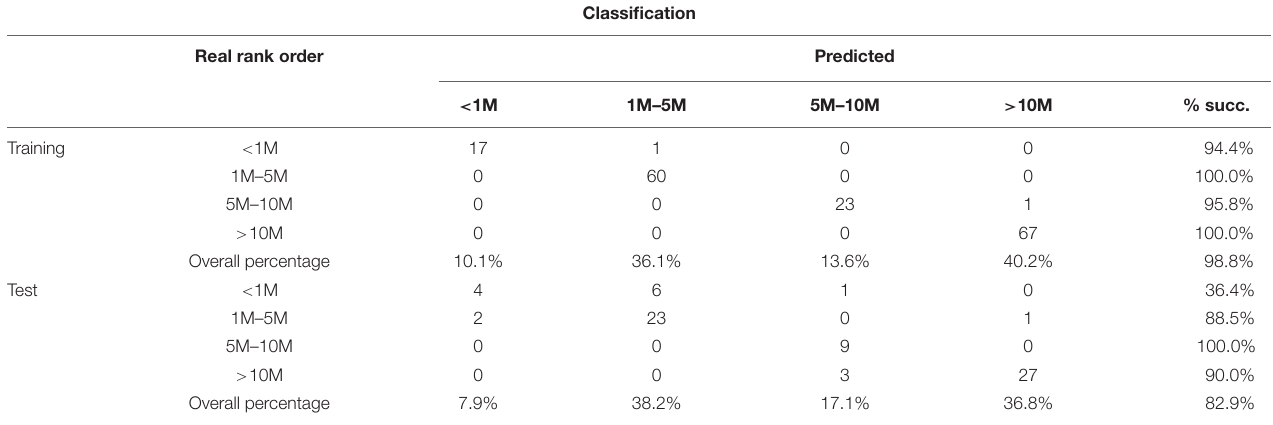
TABLE 4 | Results for the successful classification of training and test dataset applying an adjusted neural